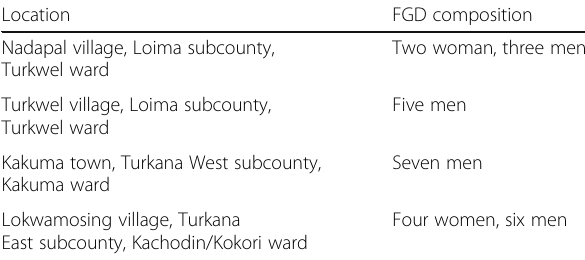
Table 3 Composition and location of FGDs with pastoralists Location FGD composition